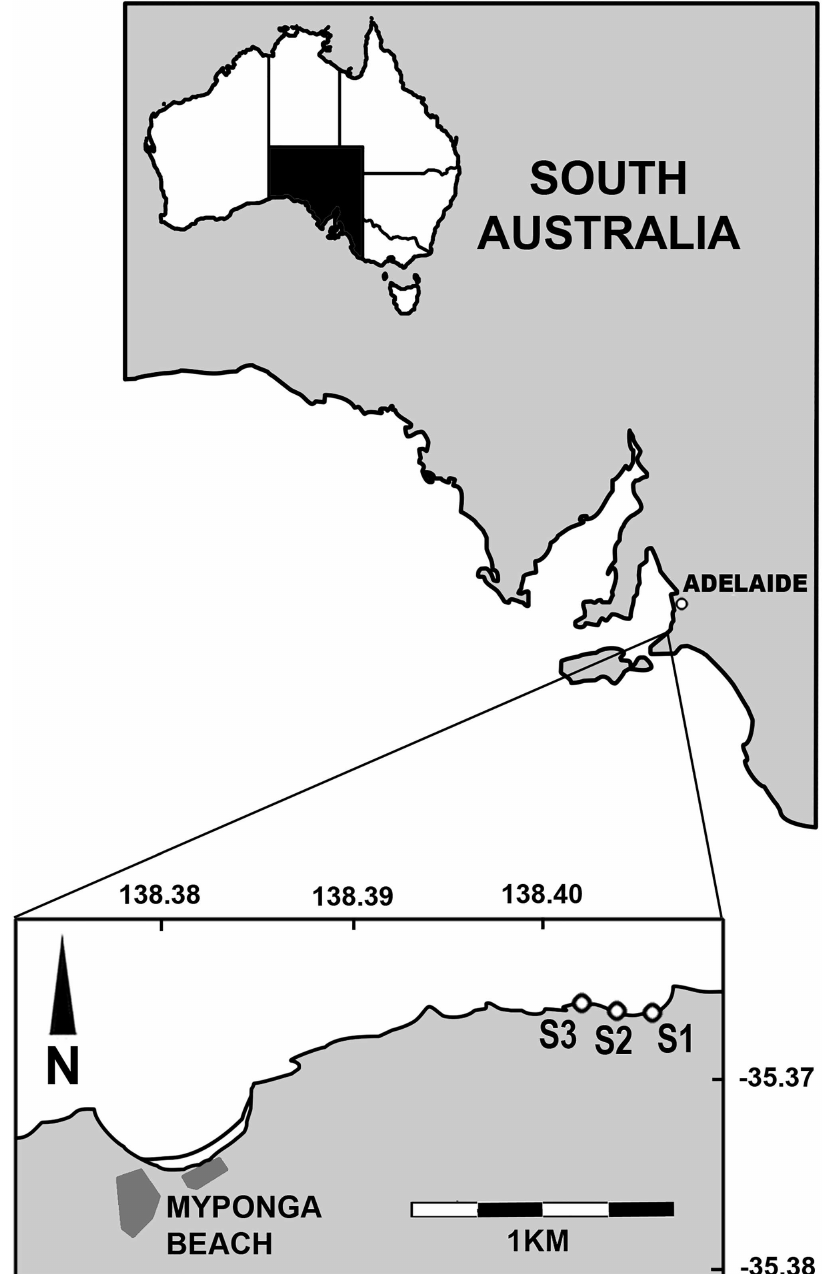
Fig 1. Map of the Myponga Beach coastline in South Australia, showing the three sites (S1, S2 and S3) where boulders were sampled.